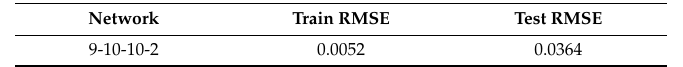
Figure 12. Error curves for the learning of cell viability and LDH activity on the training and the test set. Root mean square error ( rmse ) is employed to evaluate the performance and the network is trained for 20,000 epochs or until the rmse reaches 0.001, whichever occurs first. ( x -axis is plotted in log scale.) Table 7. Performance of the final 9-10-10-2 network on the train and test dataset. Network Train RMSE Test RMSE